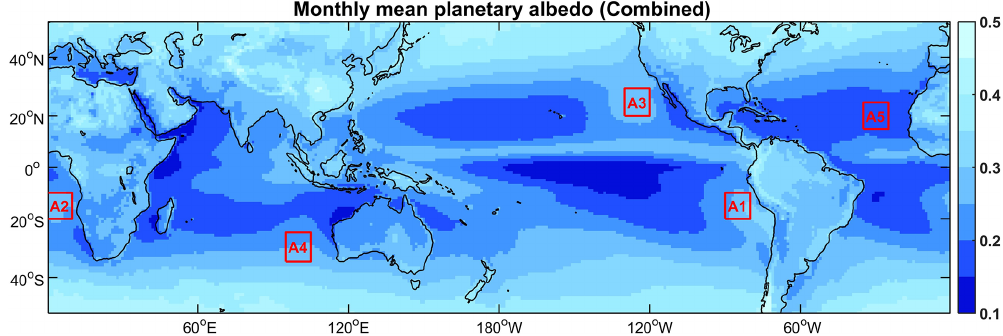
Figure 1. Near-global distribution of combined planetary albedo averaged from Aqua and Terra during 2003–2014. Red rectangular boxes indicate the five regions used chosen for the analysis: (A1) Peruvian, (A2) Namibian (A3) Californian, (A4) Australian and (A5) Canarian.